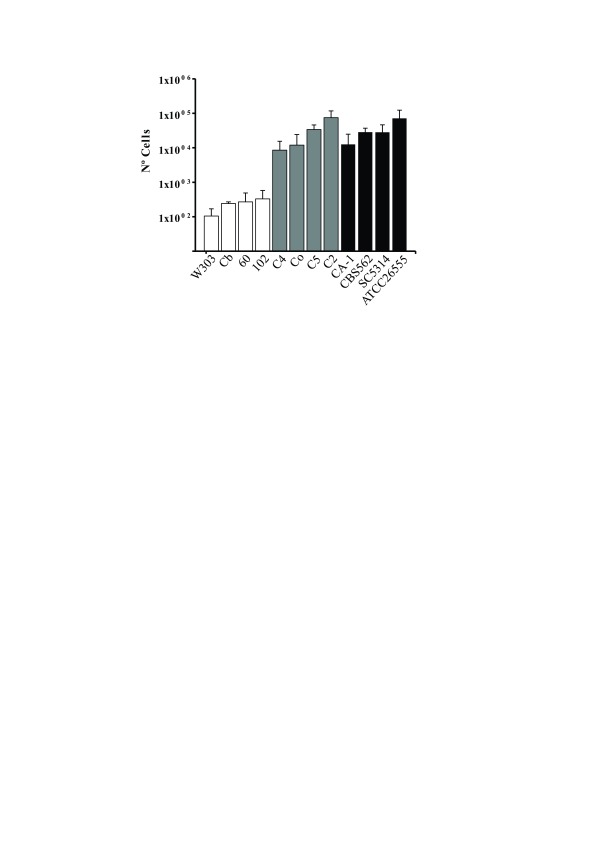
Number of yeast cells that were able to cross the endothelial barrier.To perform this assay we established HUVEC monolayers in Transwell® filter inserts in 24 well plates. 24 hours after apical addition of various strains of
S. cerevisiae,
C. albicans and
C. glabrata, yeast cells from the basolateral compartment were incubated on YPD plates and colonies were counted after one day of growth. Values were obtained after plating several dilutions of the basolateral compartment media. Average of three experiments and standard deviation is shown. To determine statistically significant data, Student
t-tests were performed in Excel with 0.05 as the
p-value.